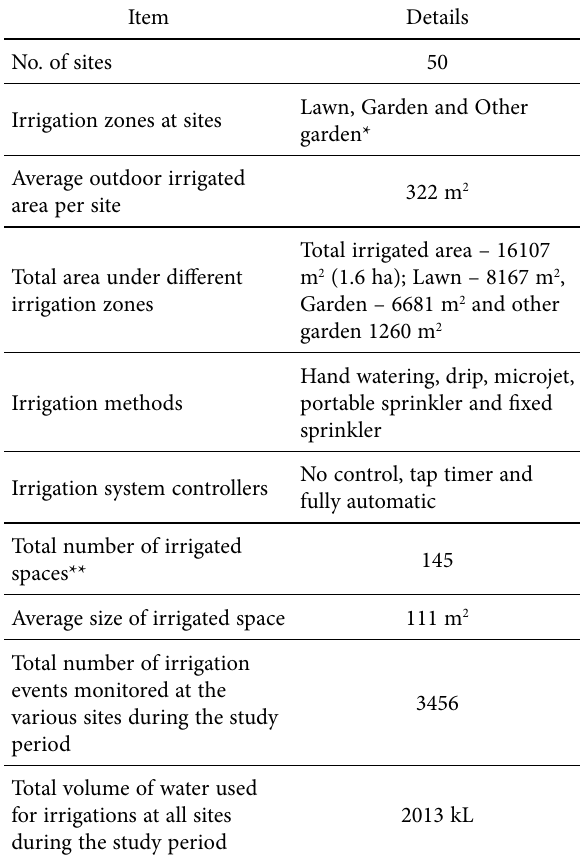
Table 1. Overview of the field